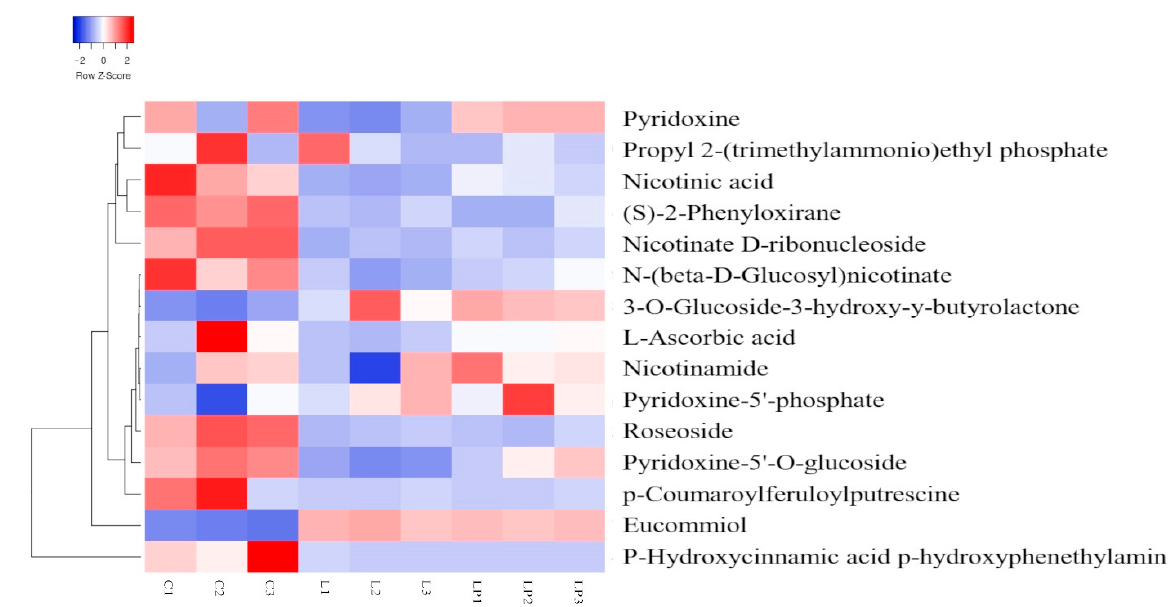
Figure 18. Heatmap and dendrogram of vitamins and other metabolites in embryos of maize under exogenous proline and low-temperature stress treatments.